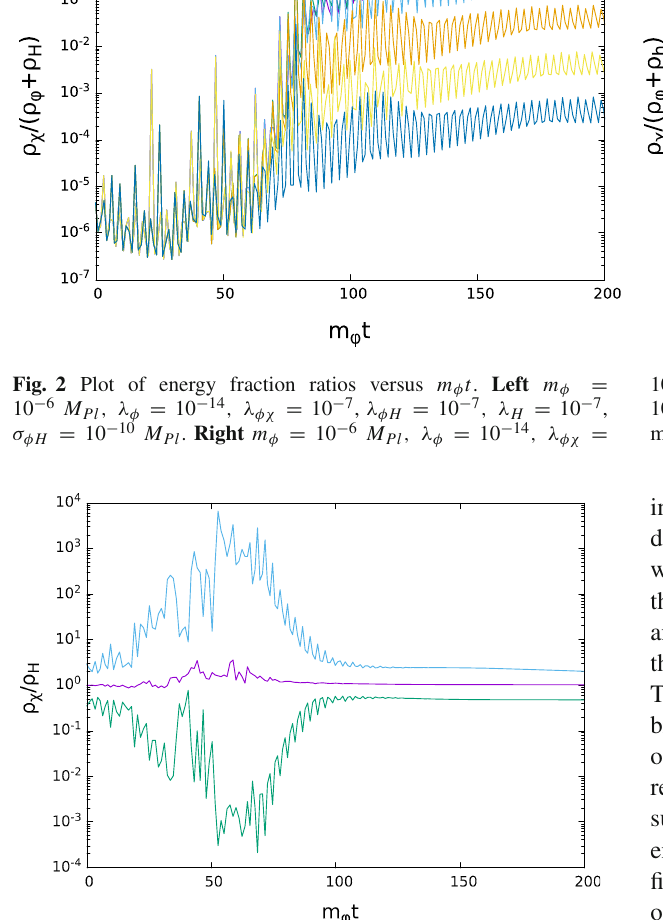
Fig. 3 Plot of energy fraction ration of χ to that of Higgs versus m φ t , for fixed m φ = 10 − 6 M Pl , λ φ = 10 − 14 , λ χ = 10 − 7 , λ H = 10 − 7 , σ φ = 10 − 10 M H Pl . The three plots from top to bottom correspond to ( λ φχ , λ φ H ) ≡ (10 − 6 , 10 − 7 ), (10 − 6 , 10 − 6 ) and (10 − 7 , 10 − 6 )